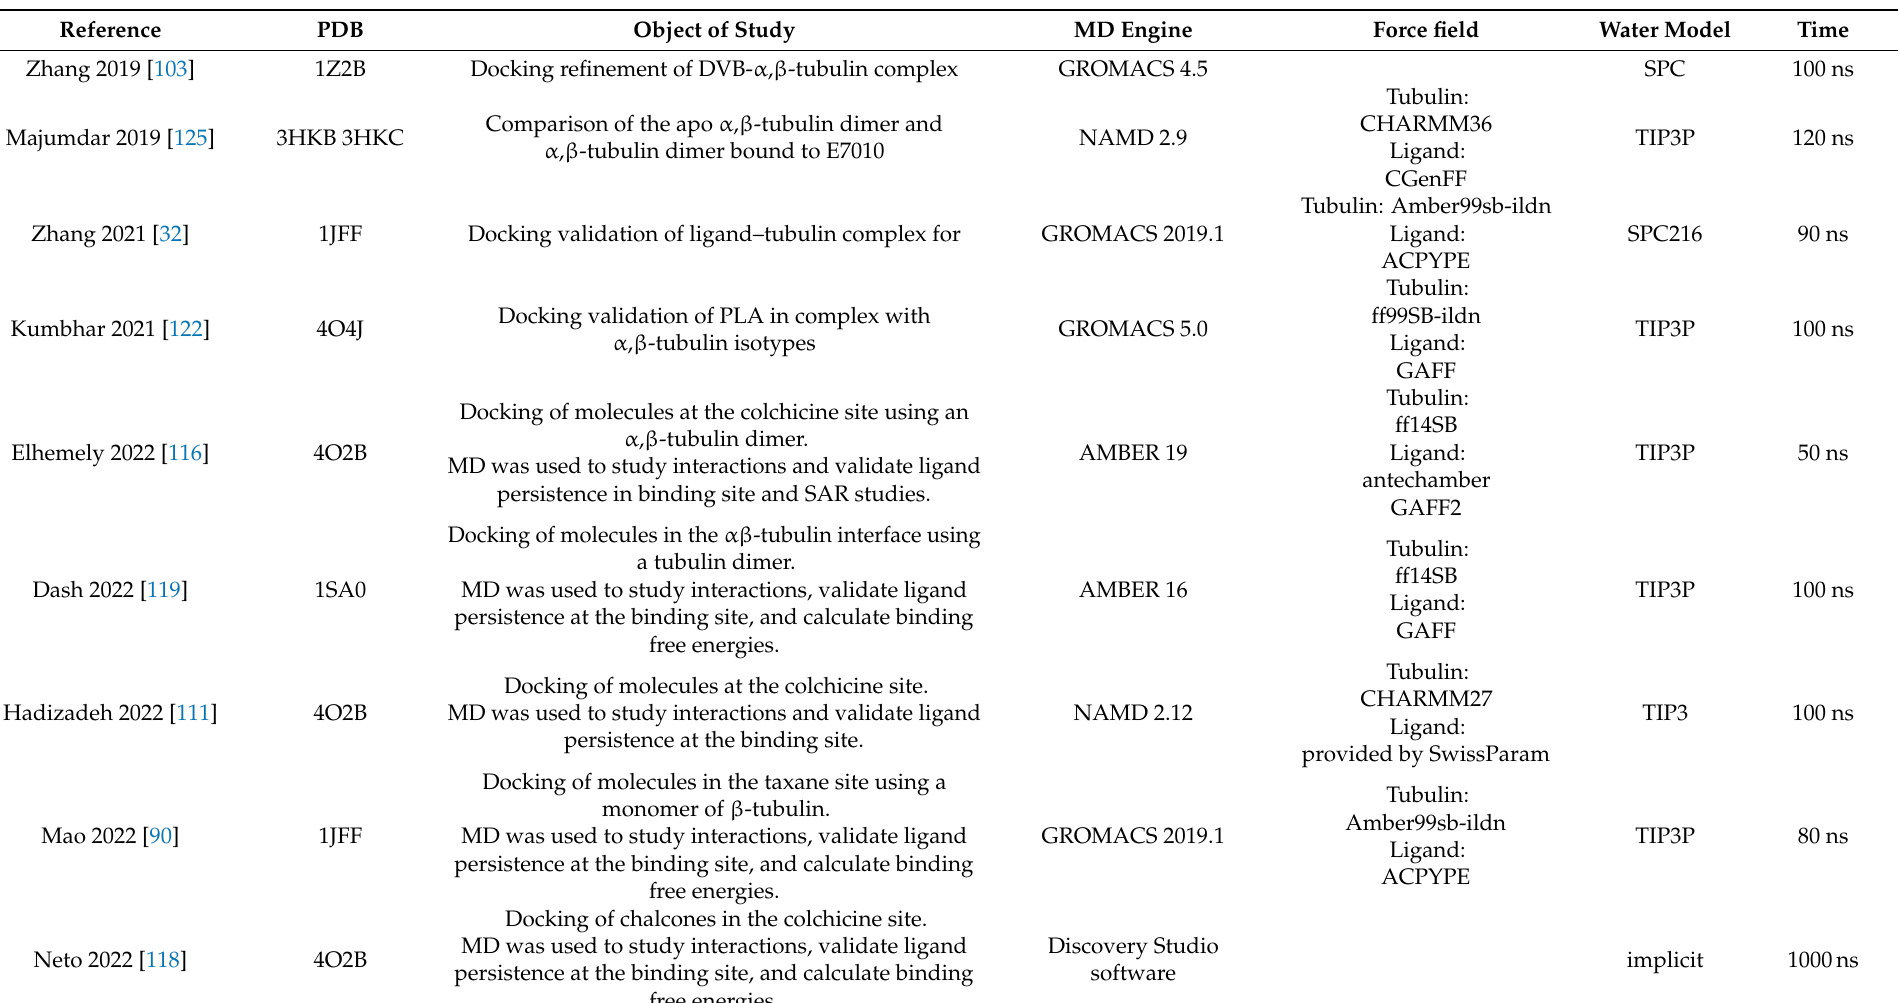
Table A6. Details of implemented classical molecular dynamics protocols for the study of tubulin-ligand